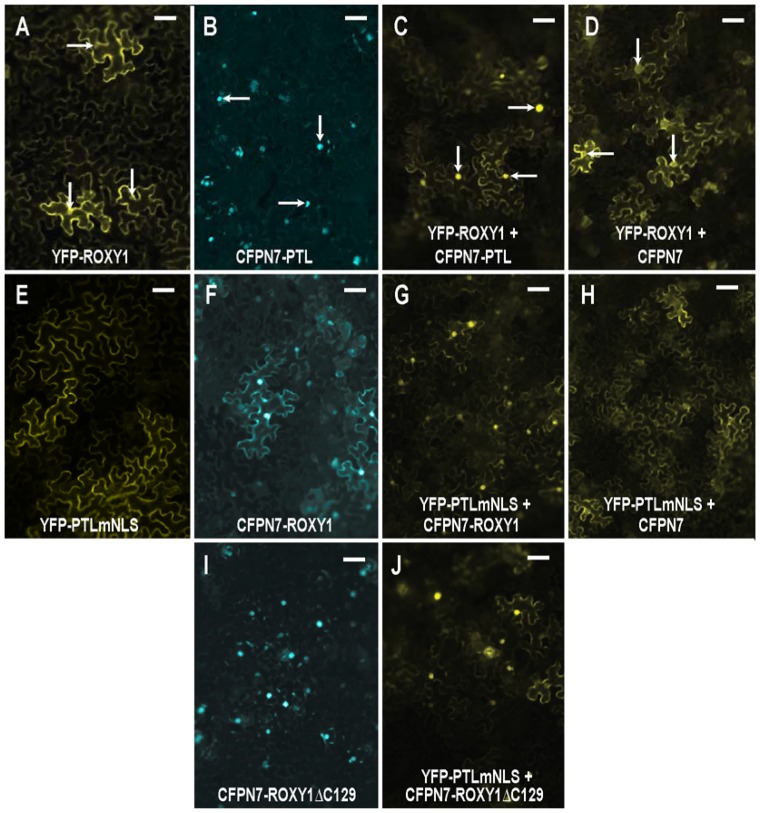
Interaction between PTL and ROXY1 proteins following transient expression in leaves of Nicotiana benthamiana.
(A–D) ROXY1 tagged with YFP accumulated in the cytoplasm, with some faint nuclear fluorescence (A) unless co-expressed with PTL tagged with the nuclear-localized CFPN7 (B), in which case significant nuclear localization of YFP-ROXY1 now occurred (C). This did not occur when ROXY1 was co-expressed with CFPN7 sequences lacking PTL (D). Arrows indicate nuclei in (A–D). (E–H) PTLmNLS tagged with YFP was cytoplasmic owing to mutation of the three NLSs (E), unless co-expressed with CFPN7-ROXY1 (F), in which case the YFP-PTLmNLS product was now significantly nuclear (G). Controls involving CFPN7 lacking ROXY1 were not effective (H). (I,J) The eight amino acids at the C-terminus of ROXY1 (deleted in CFPN7-ROXY1ΔC129) (I) were not necessary to bind with PTL, as joint expression with YFP-PTLmNLS resulted in the latter now occurring preferentially in the nucleus (J, compare E). Bars represent 50 μm.